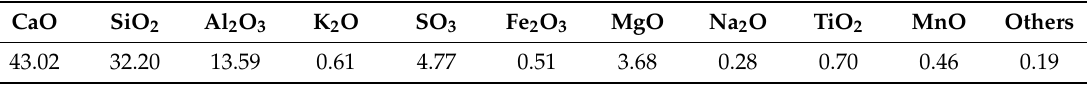
Table 2. The cations were measured using inductively coupled plasma atomic emission spectroscopy and anions were quantified using ion chromatography.